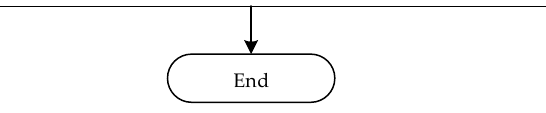
Figure 5. Flow diagram of the proposed method.